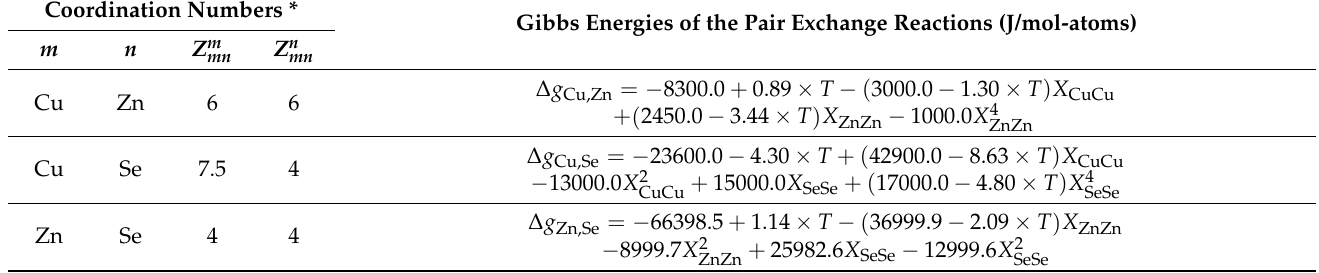
Table 5. The present optimized parameters of the liquid phase in the Cu-Zn, Cu-Se and Zn-Se systems. Coordination Numbers * Gibbs Energies of the Pair Exchange Reactions